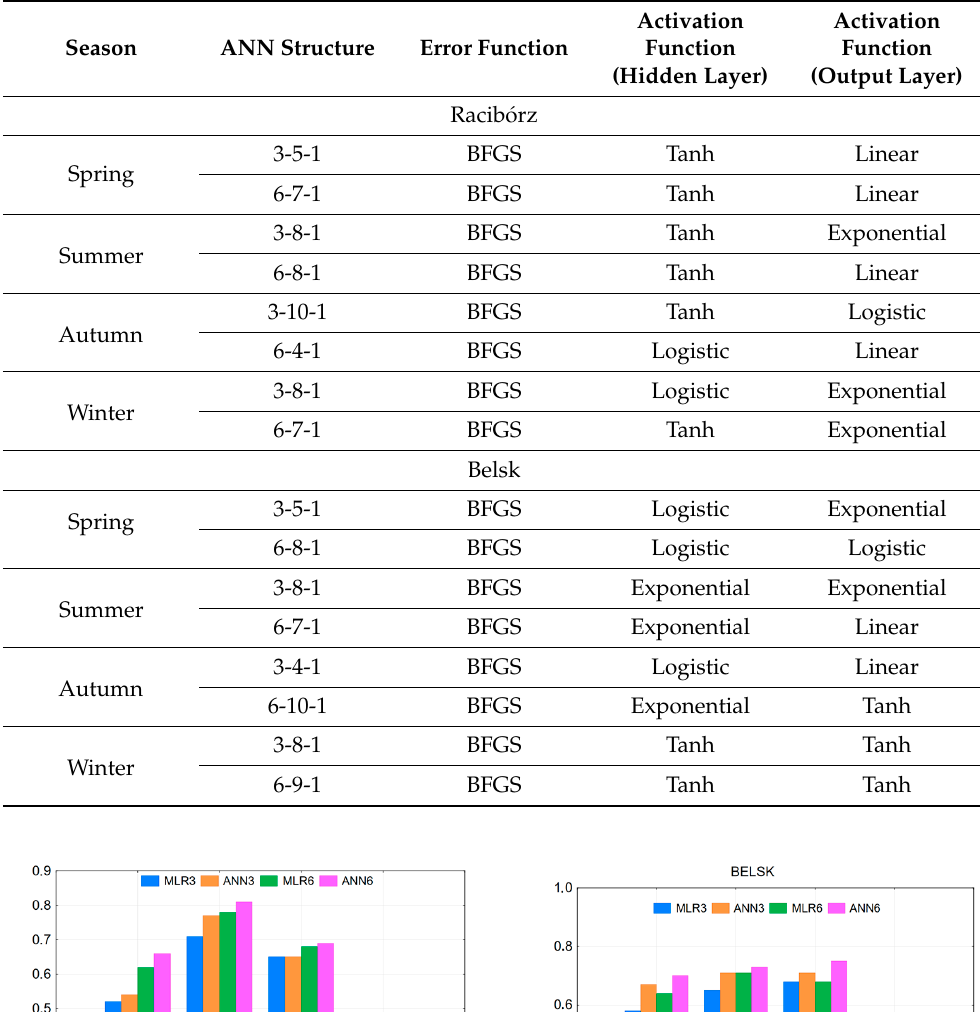
Table 3. Structure of ANN networks selected for surface O 3 prediction.